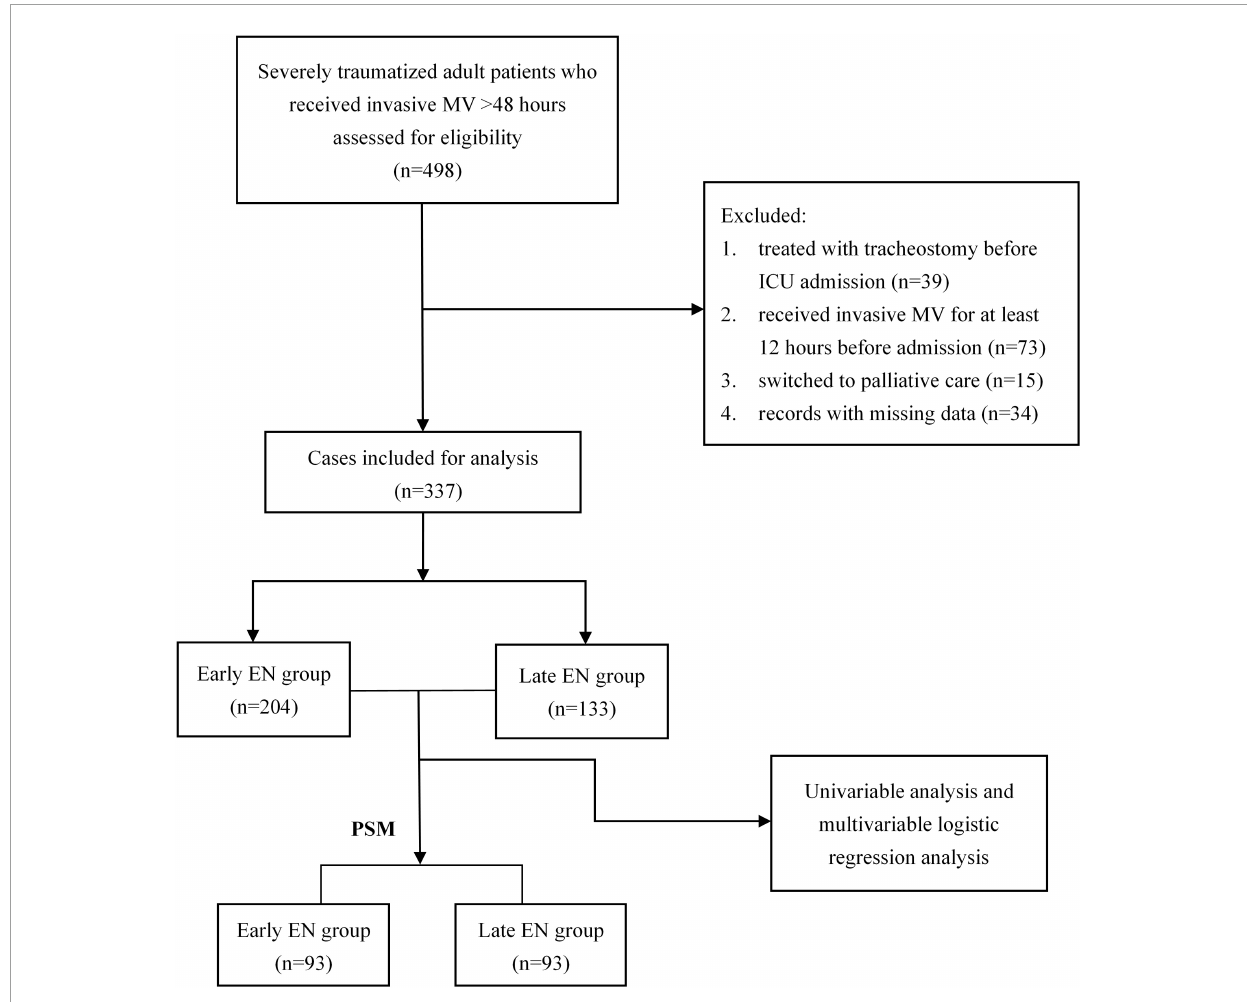
FIGURE1 Flow chart of the study. ICU, intensive care unit; EN, enteral nutrition; MV, mechanical ventilation; PSM, propensity score matching.